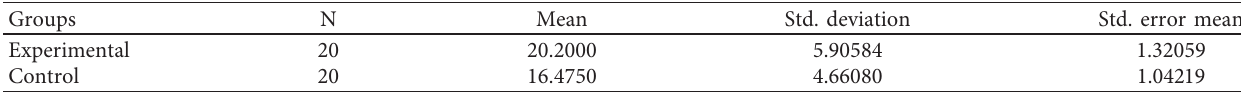
Table 4: Results of descriptive statistics (posttest).